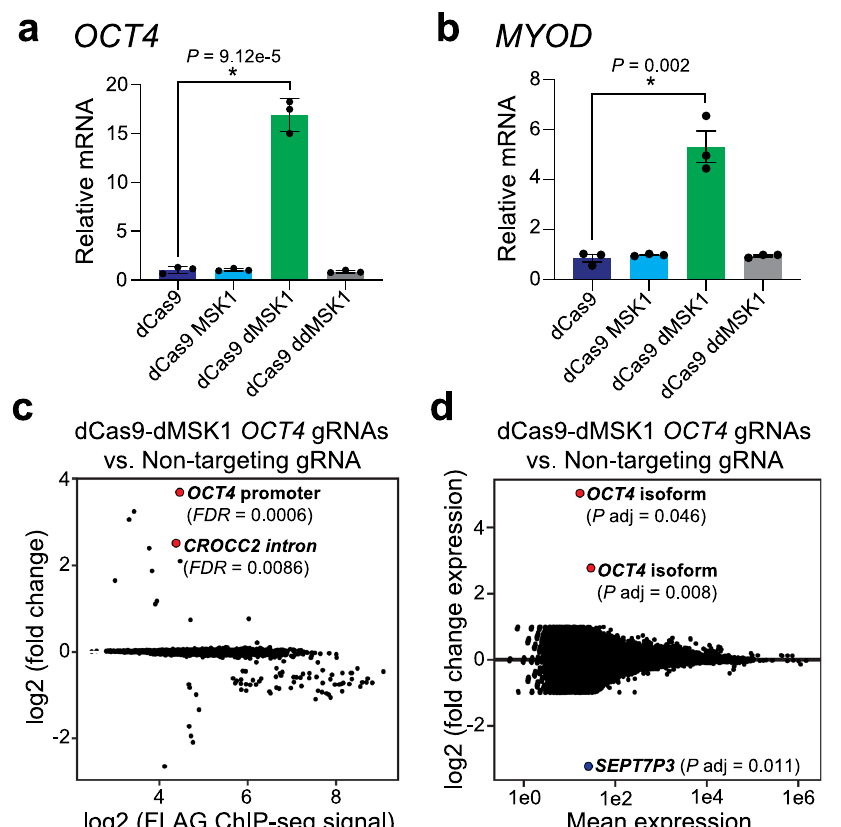
Fig. 3 dCas9-dMSK1 activates endogenous human promoters with high genome and transcriptome-wide speci fi city. a , b RT-qPCR for OCT4 or MYOD mRNA levels 72 h post-transfection of dCas9, dCas9-MSK1, dCas9-dMSK1, or dCas9-ddMSK1 and 4 corresponding promoter-targeting gRNAs. Two-sided t -test, * P < 0.05; n = 3 independent experiments for both panels; error bars, s.e.m. c DESeq2 analysis of FLAG ChIP-seq binding data from HEK293T cells transiently co-transfected with dCas9-dMSK1 and four OCT4 promoter-targeting gRNAs compared to HEK293T cells transiently co-transfected with dCas9-dMSK1 and a non-targeting gRNA. Data were analyzed using the Wald test. Red circles indicate false discovery rate (FDR) < 0.01; d DESeq2 analysis of RNA-seq data from HEK293T cells transiently co-transfected with dCas9-dMSK1 and four OCT4 promoter-targeting gRNAs compared to HEK293T cells transiently co-transfected with dCas9-dMSK1 and a non-targeting gRNA. Data were analyzed using the Wald test and the adjusted P value ( P adj ) was calculated using the Benjamini and Hochberg method. Signi fi cantly upregulated mRNAs ( OCT4 isoforms) are shown as red circles ( P adj < 0.05) and a signi fi cantly downregulated gene ( SEPT7P3) is designated with a blue circle ( P adj < 0.05). Source data are available in the Source data fi